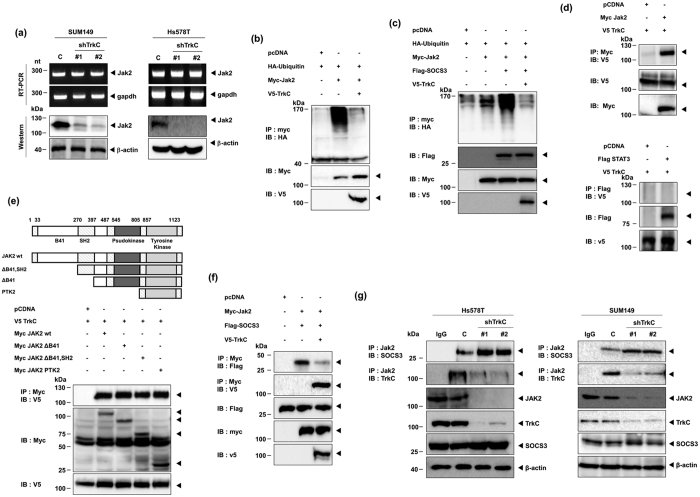
TrkC induces JAK2 stabilization by inhibiting SOCS3-mediated degradation of JAK2.(a) RT-PCR and western blot analysis of JAK2 expression in Hs578T and SUM149 control-shRNA or TrkC-shRNA cells. GAPDH and β-actin were used as loading controls. (b) Immunoblot analysis of whole-cell lysates and immunoprecipitates derived from 293T cells transfected with V5-TrkC, HA-Ubiquitin, and Myc-Jak2 constructs as indicated. (c) Immunoblot analysis of whole-cell lysates and immunoprecipitates derived from 293T cells transfected with V5-TrkC, HA-Ubiquitin, Flag-SOCS3, and Myc-Jak2 constructs as indicated. (d) TrkC interacts with JAK2. Immunoblot analysis of whole-cell lysates and immunoprecipitates derived from 293T cells transfected with the V5-TrkC and Myc-Jak2 constructs as indicated. (e) Identification of the JAK2 region responsible for TrkC interaction and immunoblot analysis of whole-cell lysates and immunoprecipitates derived from 293T cells transfected with the V5-TrkC and Myc-Jak2 deletion constructs as indicated. (f) Identification of the inhibition of SOCS3-JAK2 complex formation by TrkC and immunoblot analysis of whole-cell lysates and immunoprecipitates derived from 293T cells transfected with the V5-TrkC, Flag-SOCS3, and Myc-Jak2 constructs as indicated. (g) Identification of endogenous SOCS3-JAK2 complexes in Hs578T and SUM149 control-shRNA or TrkC-shRNA cells.